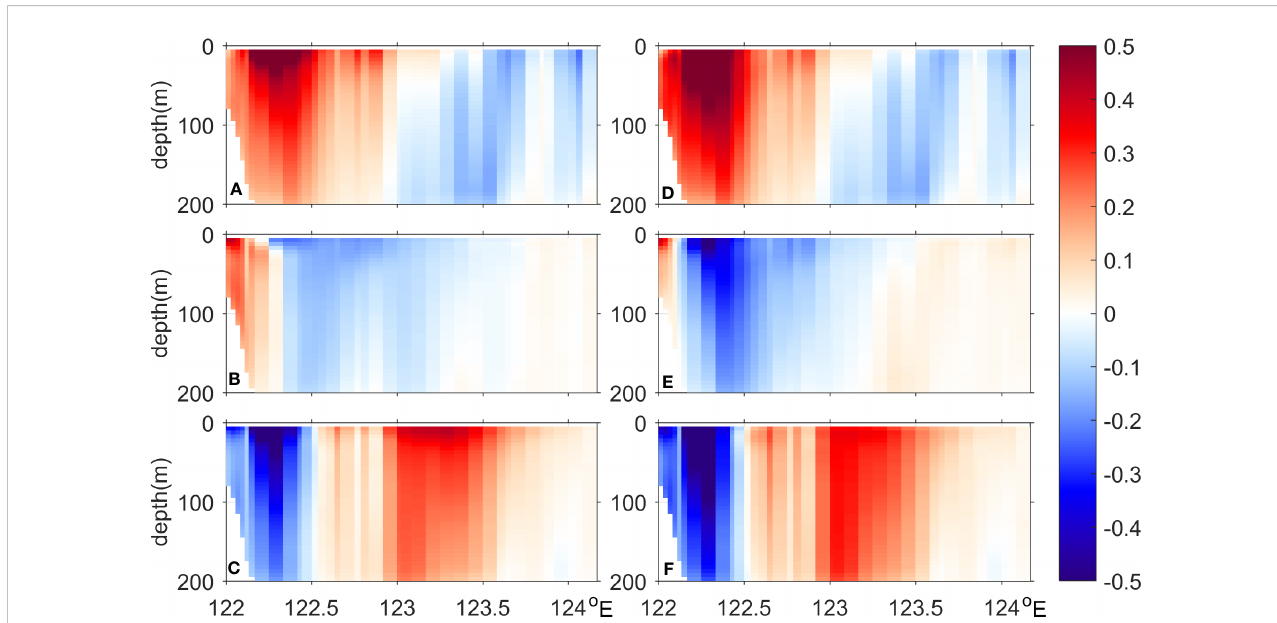
FIGURE 7 The (left panel) cross-shelf velocity (m/s) and (right panel) phosphate fl ux (kg/ms) in the (A, D) control run, and their variations under the effect of (B, E) cyclonic and (C, F) anticyclonic eddies at t=30